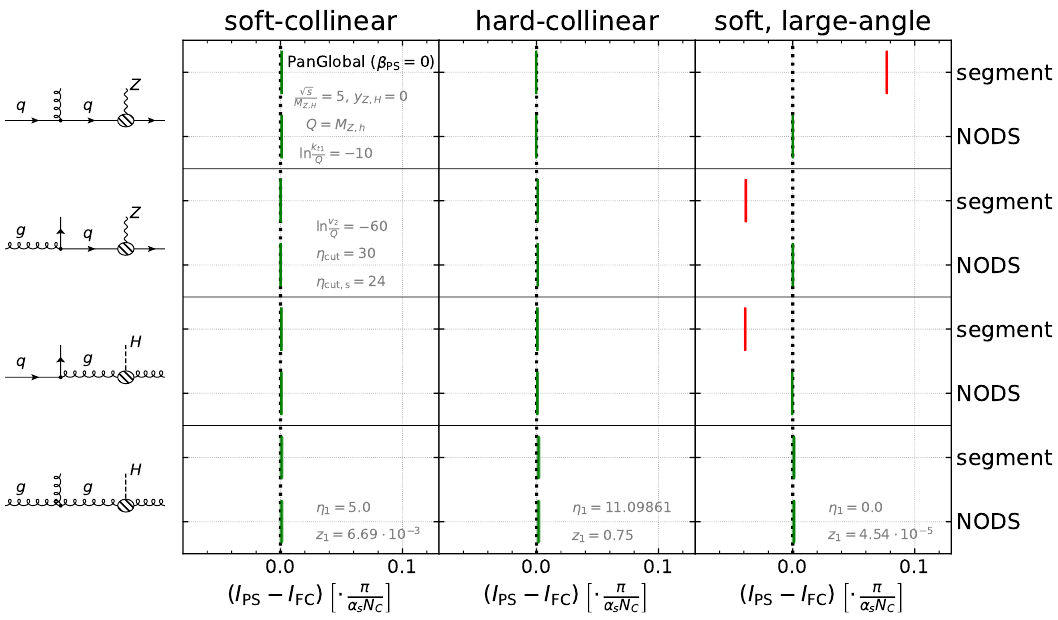
Figure 10. Normalised deviation of the integrated rate of a single soft emission (emission 2 ), as produced by the parton shower I from the configurations in the left-hand column, relative to the PS exact analytic results I quoted in appendix C. We show four configurations, two for the q ¯ q → Z FC event, and one for the gg → H event, and only consider initial-state splittings (the results for final-state splittings may be found in ref. [44]). For each configuration, we show three kinematics regimes for the first emission, as labelled at the top of the plot (and detailed at the bottom). For each configuration and kinematic regime, we show results for both the segment and NODS colour schemes. The colours of the lines indicate whether the result is consistent with